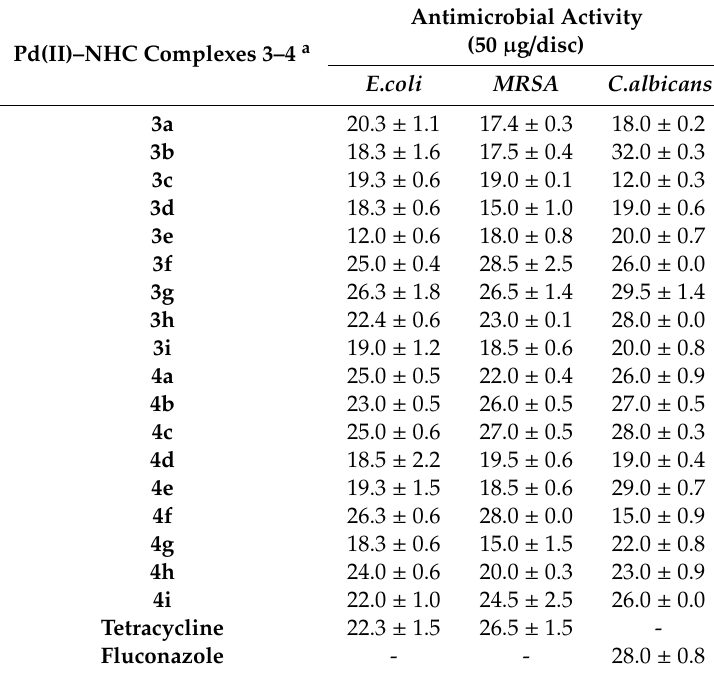
Table 2. Antimicrobial profile of synthesized derivative Pd(II)–N-heterocyclic carbene (NHC) complexes